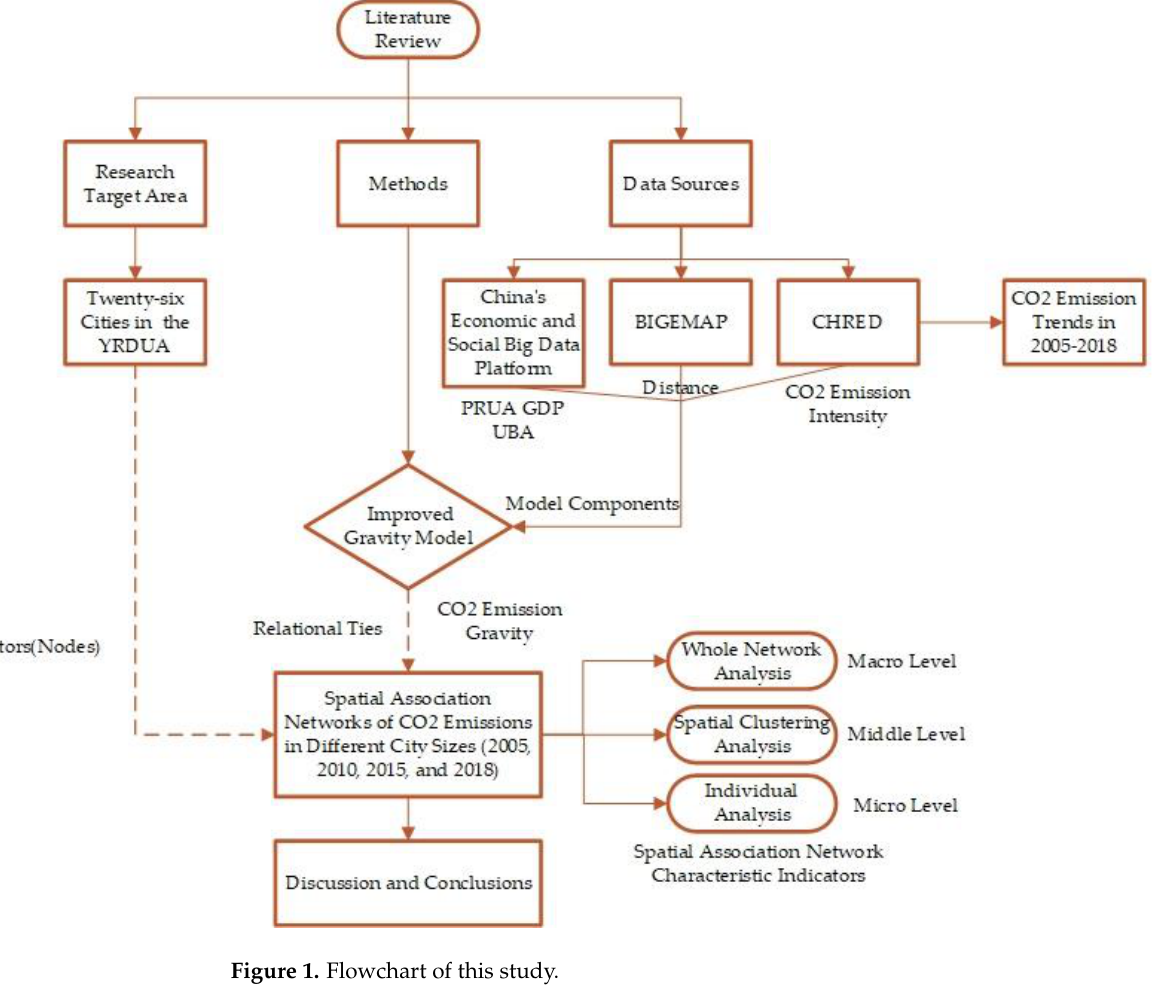
Figure 1. Flowchart of this